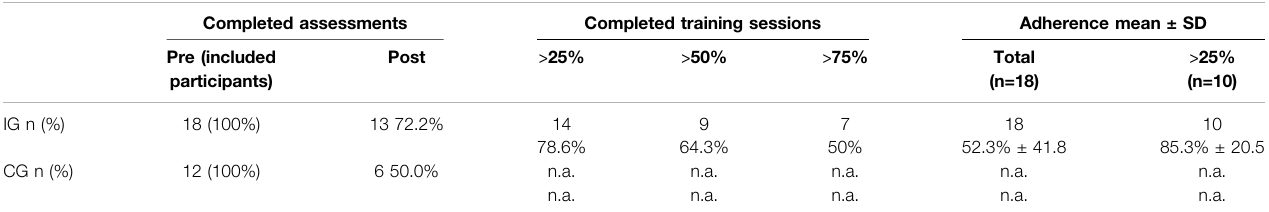
TABLE 4 | Results on feasibility based on logging